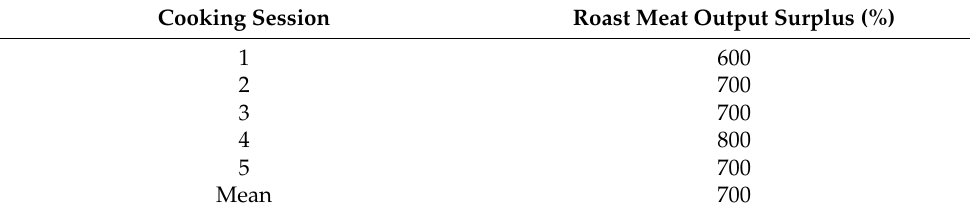
Table 14. A summary of data from the roasting output test. Average Roast Meat Output (Unit) Set-Up a b c d e Experimental 7 8 8 9 8